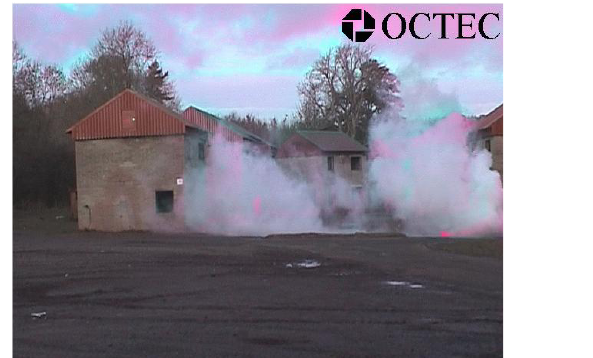
l αβ kolor transformacije i Laplasove piramide Figure 8 – Result of the fusion of the color and monochromatic images in Figure 3 with the l αβ color transform and the Laplacian